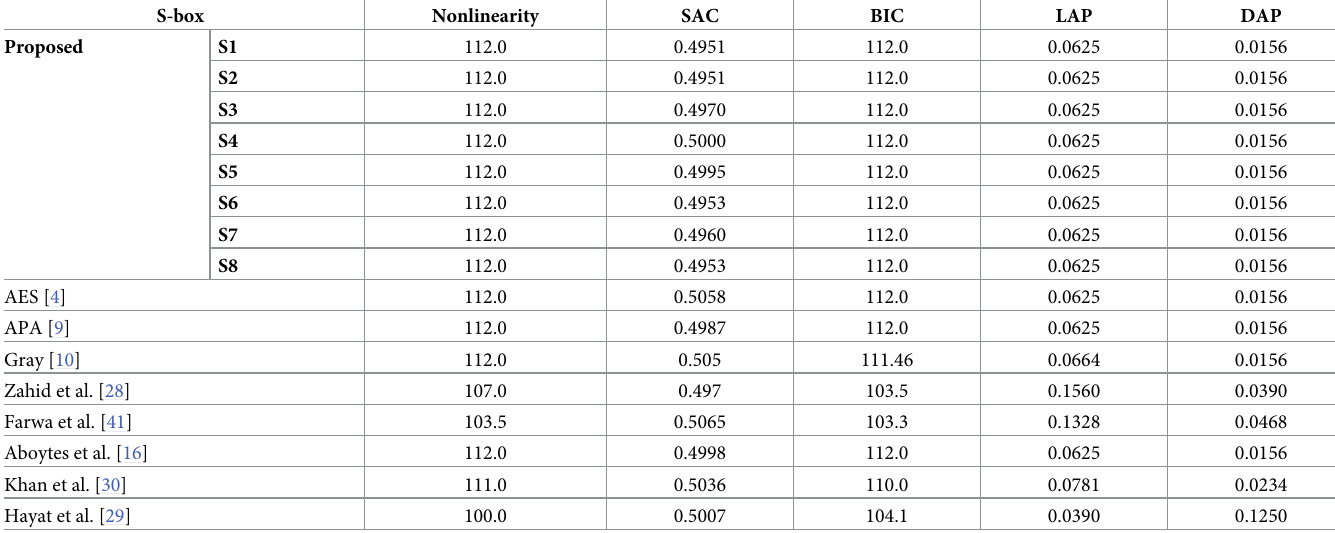
Table 10. Numerical results of the S-box testing parameters obtained for our proposals in comparison with the existing S-boxes. S-box